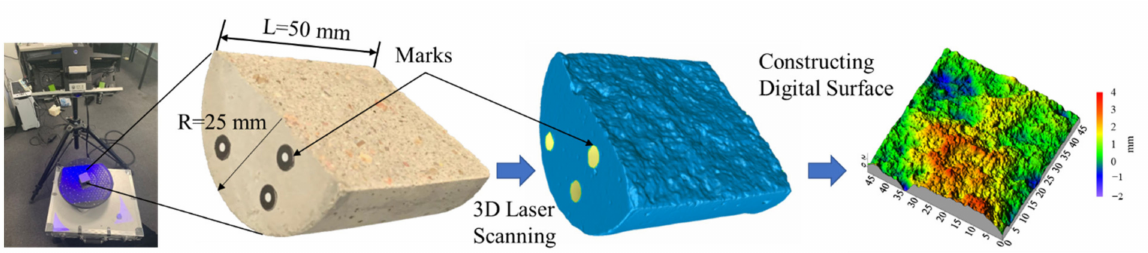
Figure 4. Obtainment process of fracture surfaces by 3D laser